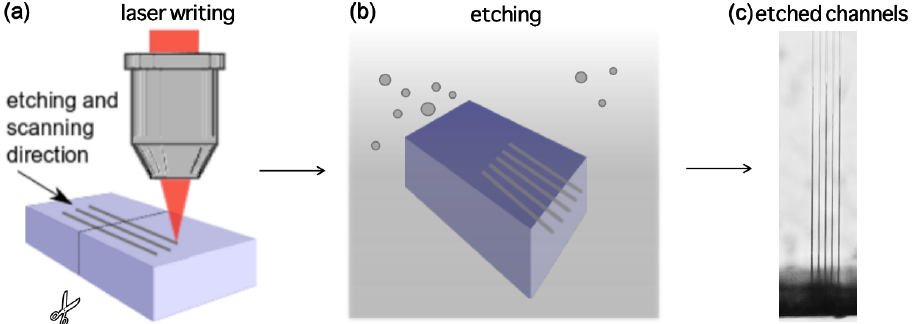
Figure 1. The sequence of the performed experiment. ( a ) First of all, laser modifications are inscribed inside the volume of glass in the XY plane. The sample is cut in the middle perpendicularly to the inscribed lines, the cut edge is polished. ( b ) Then, etching is performed in various enchants. ( c ) Finally, etched single line channel lengths are measured under the optical